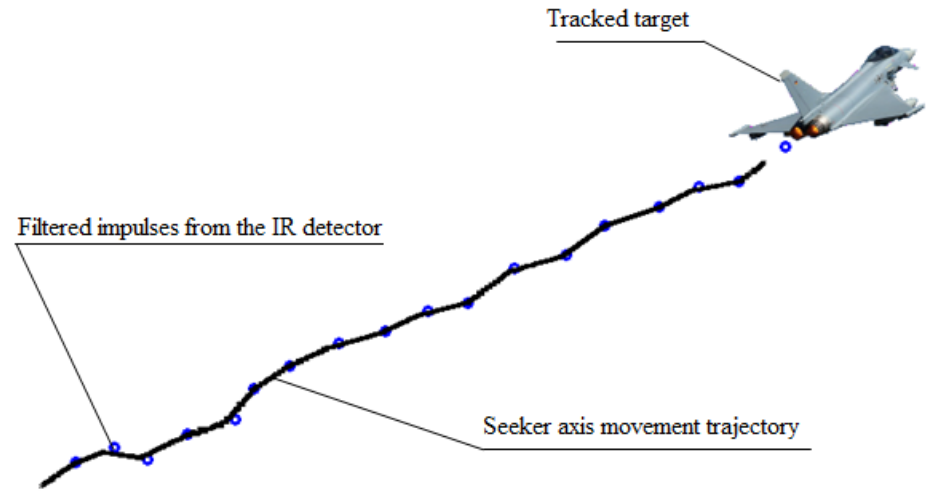
Figure 8. Tracking of a detected air target without signal filtering.